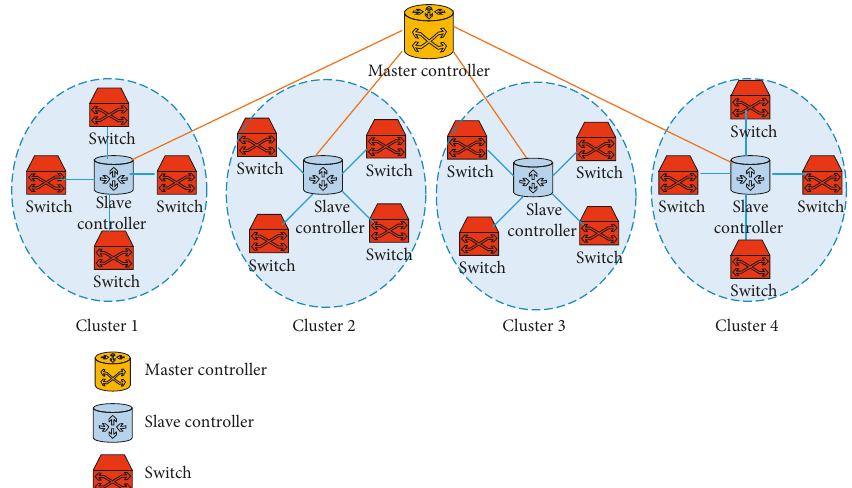
Figure 2: Four slave controllers connected to a master controller in a master-slave architecture.